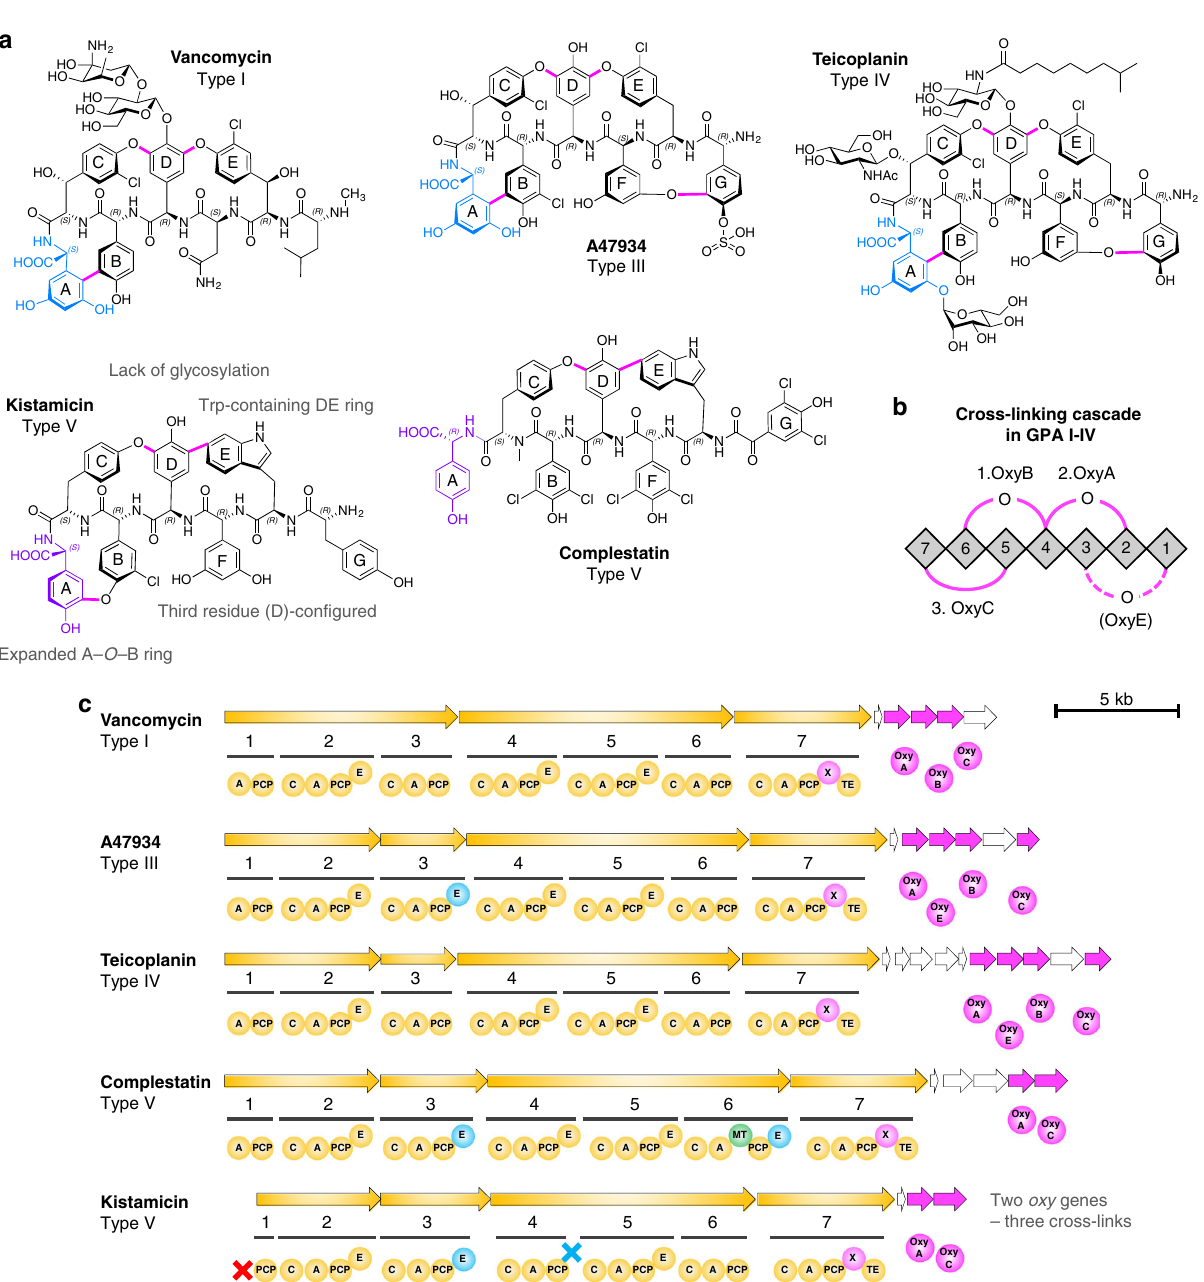
Fig. 1 GPA structures and NRPS/Oxy interplay. a Structure of different types of GPAs shown for vancomycin (Type I), A47934 (Type III), teicoplanin (Type IV), kistamicin (Type V) and complestatin (Type V). Major structural differences between kistamicin and Type I – IV GPAs include: the replacement of the AB ring required for the activity of standard GPAs with an enlarged A- O -B ring; the replacement of the D- O -E ring with a DE ring that incorporates a tryptophan residue; the opposite con fi guration of the 3rd peptide residue (D instead of L); and the lack of glycosylation. C-terminal residues of GPAs are coloured for 3,5-dihydroxyphenylglycine (3,5-Dpg, light blue) and 4-hydroxyphenylglycine (4-Hpg, violet). P450 catalysed intramolecular crosslinks are indicated in pink. b P450-catalysed crosslinking cascade performed by fi rst OxyB, (then optional OxyE), OxyA and fi nally OxyC into type I – IV GPA heptapeptides. Numbering of amino acids is listed according to the timing of amino acid incorporation, i.e. from 1 – 7. c Part of the respective GPA biosynthetic gene clusters involving the NRPS (yellow) and the P450 enzymes (pink); other genes are also indicated (white). The NRPSs are divided into seven modules with a number of catalytically active domains (yellow circles). In the last module, the Oxy-recruiting domain X is present (light pink). Additional domains (E domains (blue), MT domain (green)) and missing domains (red cross) are indicated. Presence and type of Oxys within the GPA biosynthesis is shown (pink circles). Kistamicin has three crosslinks, but only two Oxy encoding genes in the cluster, an OxyA and an OxyC enzyme. Domain de fi nitions: A, adenylation domain; C, condensation domain; E, epimerisation domain; PCP, peptidyl carrier protein; MT, methyltransferase; X,